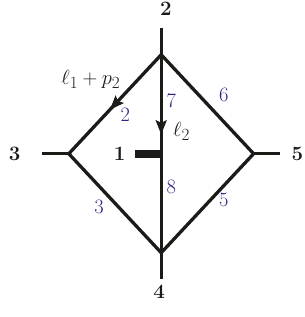
Figure 4. Double-box with 4 master